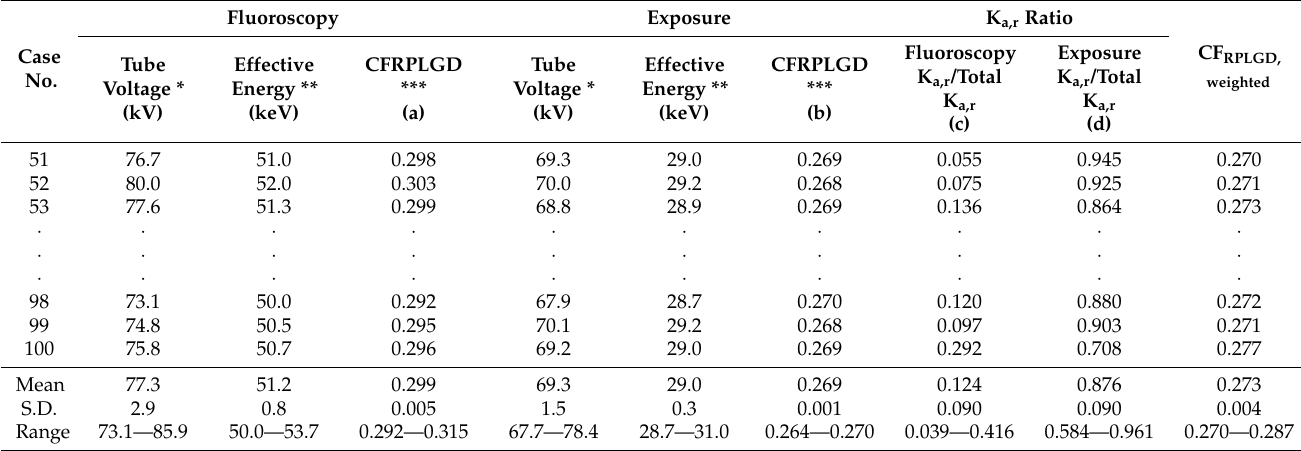
Table 4. RPLGD energy compensation factors weighted by the K a,r ratio (validation data set: n = 50).